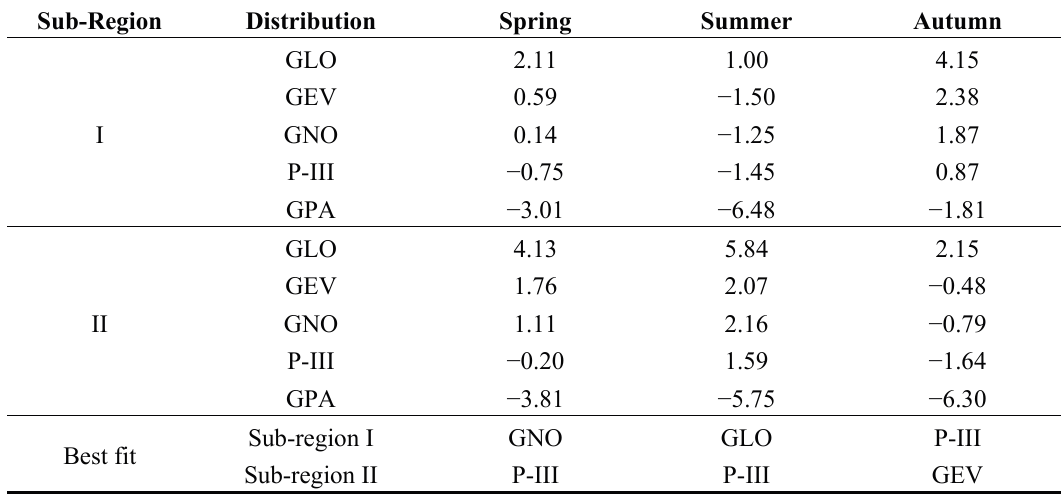
Table 6. Calculation of statistics Z DIST for distribution fitting function of seasonal precipitation within